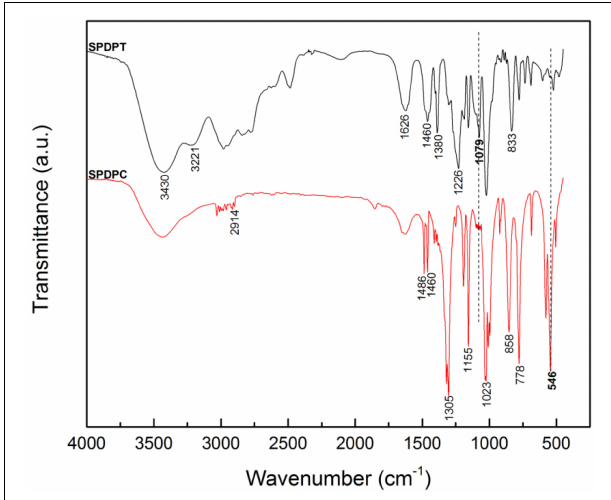
FIGURE 2 | Infrared spectra of SPDPC and SPDPT.